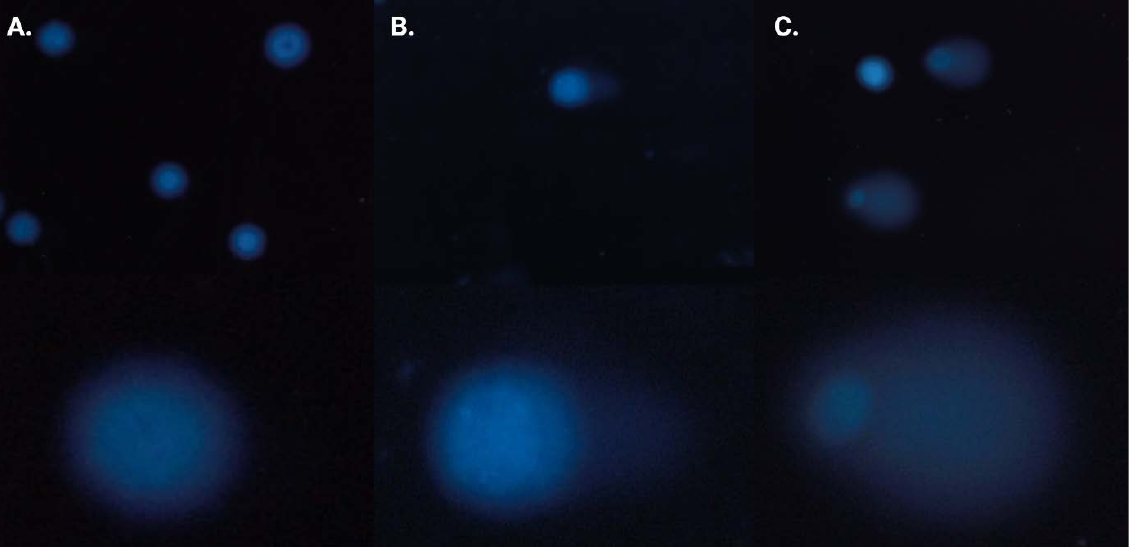
Figure 7. Alkaline comet assay results: images of comets were obtained in an alkaline comet assay for the PC-3 cell line: ( A ) control samples, ( B ) cells treated with 2 × IC 50 (0.34 µM) of MM139 , and ( C ) 20 µM bleomycin. Upper images are shown in magnification of 20×. Lower images are shown in arbitrary magnification.